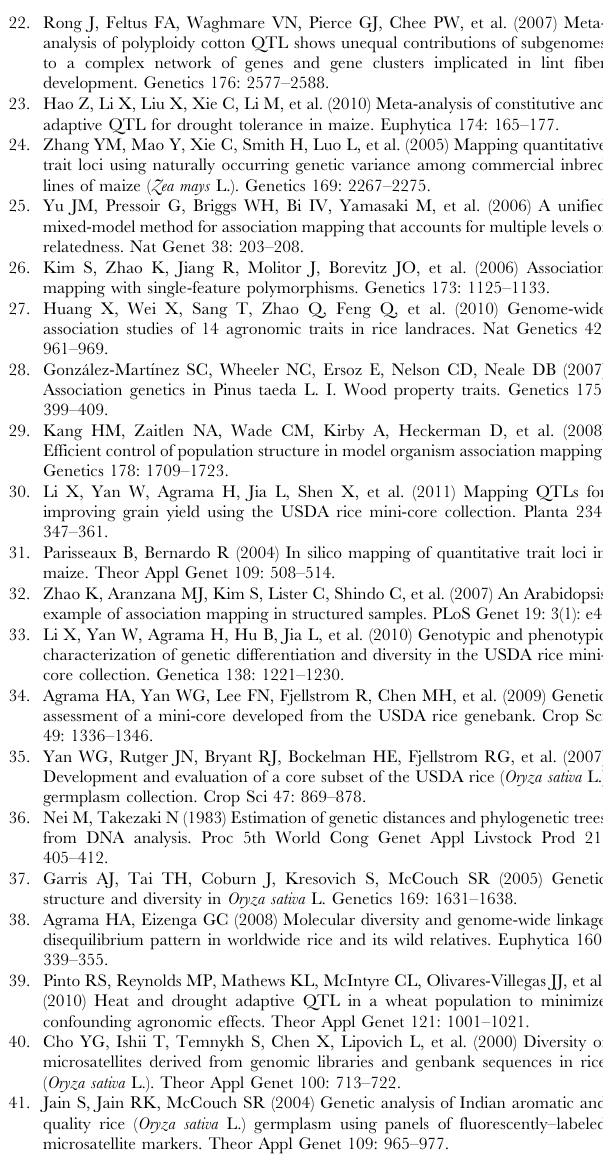
Table S4 Comparison of allelic effect of four constitu- tive marker loci at two locations, Stuttgart, Arkansas and Beaumont, Texas. RM431 for Plant height, RM471 and Rid12 for Plant weight, and RM24011 for Panicle